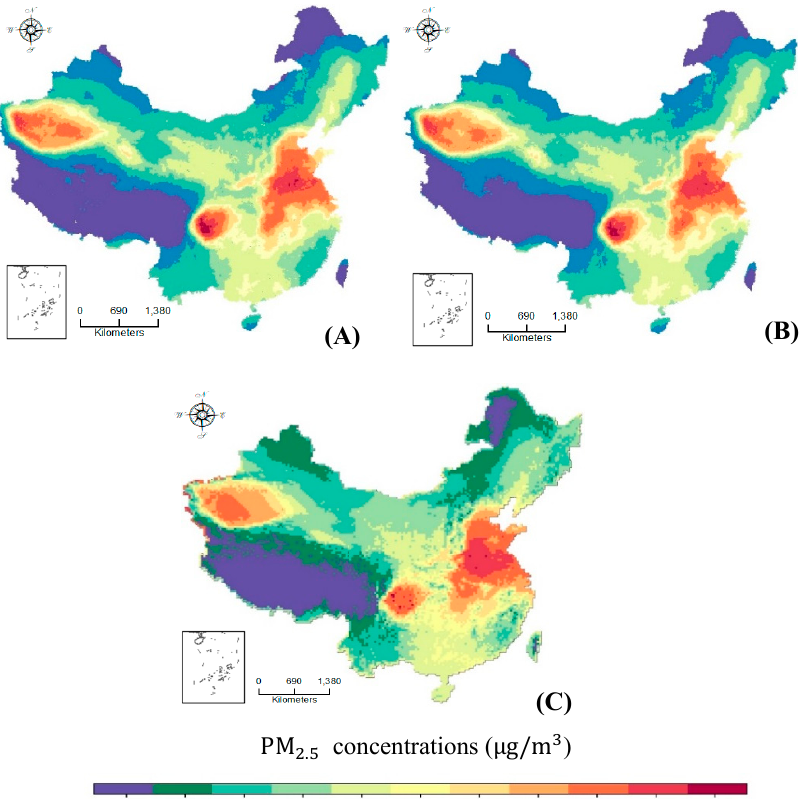
Figure 4. Original ( A ), estimated spatial distribution of PM 2.5 annual mean concentrations in 2010 ( B ) by the deep CNN model and ( C ) Geographic Weighted Regression (GWR) model, with the four influencing factors (population spatial density, GDP spatial density, terrain, and LULC) over China in 2010.